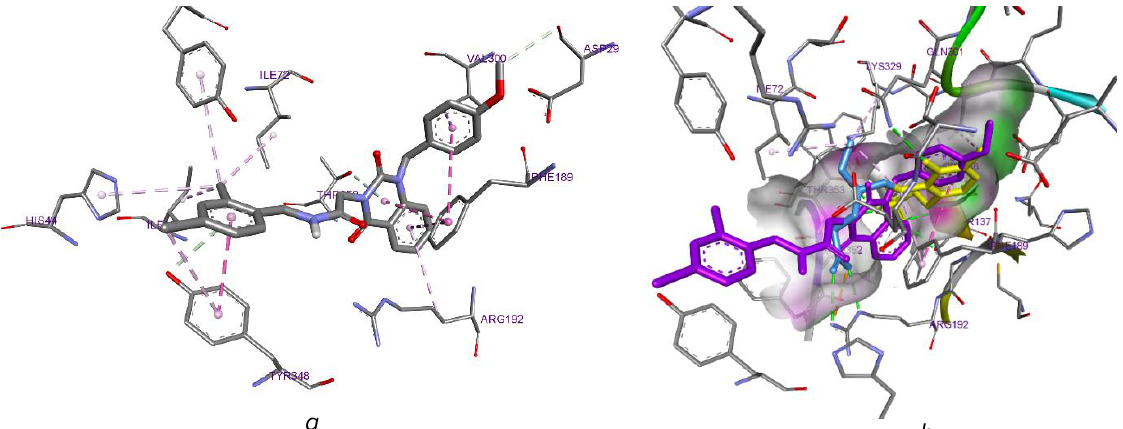
Fig. 7. 3D conformation in the active site of GABA